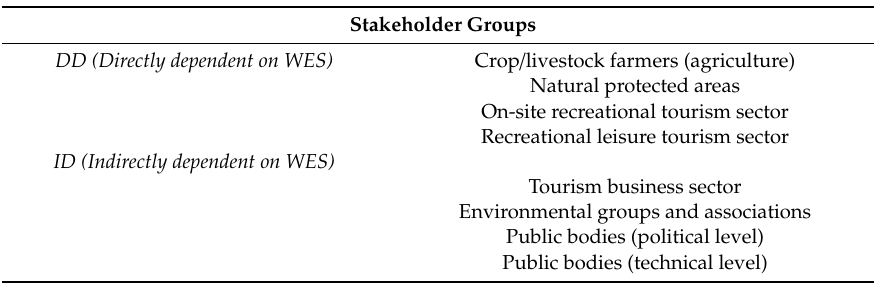
Table A1. Stakeholder